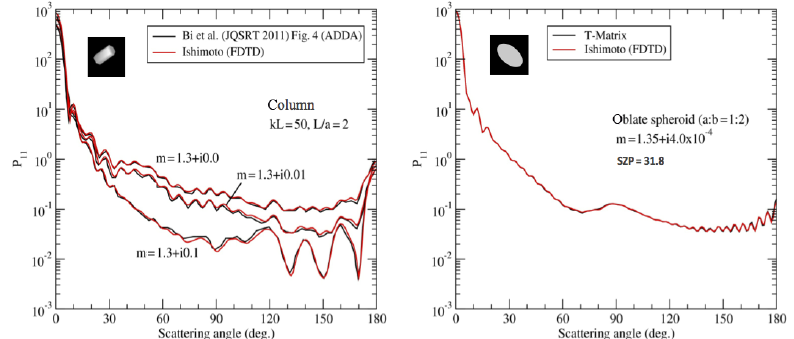
Figure 3. Comparison of the phase functions of randomly oriented column and spheroid particle from FDTD, T-matrix, and ADDA methods.